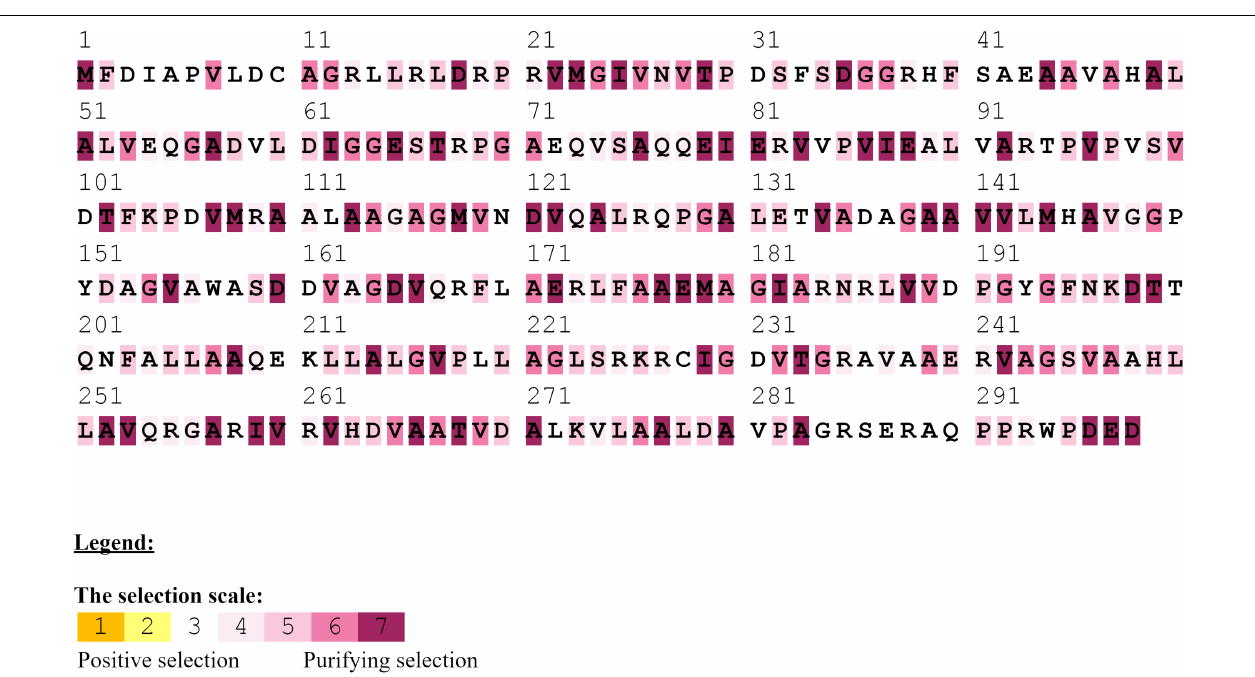
FIGURE 8 | Selection pressure (Ka/Ks) measured along folP among S. acidaminiphila strains. The strong signals of purifying selection are defined as the loci with Ka/Ks < 0.8. Overall, 72 loci of strong signals of purifying selection is wide-spread across the entire gene